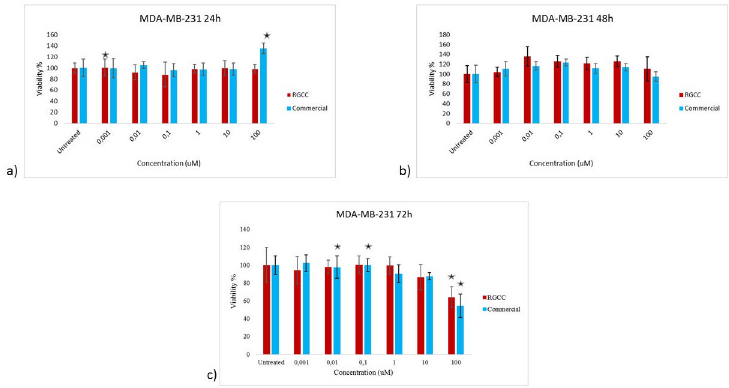
Fig 2. Viability of MDA-MB-231 cells after the treatment with various concentrations of genistein R.G.C.C. and genistein commercial. MTT results at a) 24 h, b) 48 h and c) 72 h. The � represents the statistically significant results P -value < 0.05.